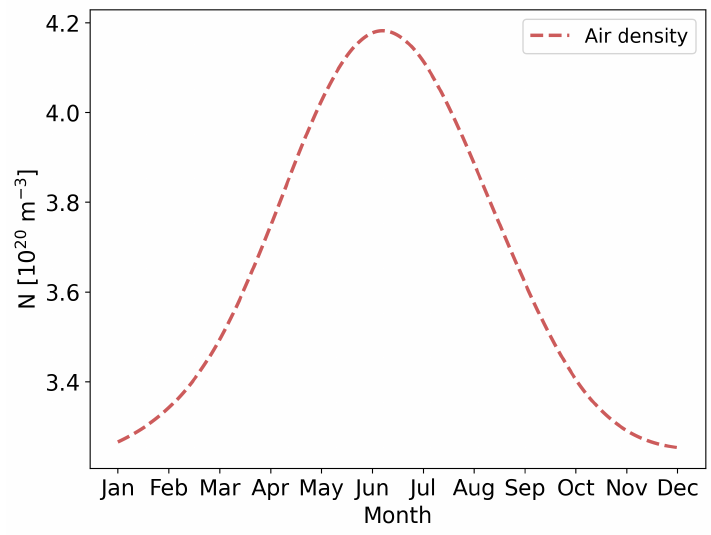
Figure 9. Monthly variation of air number density N at a height of 80 km.